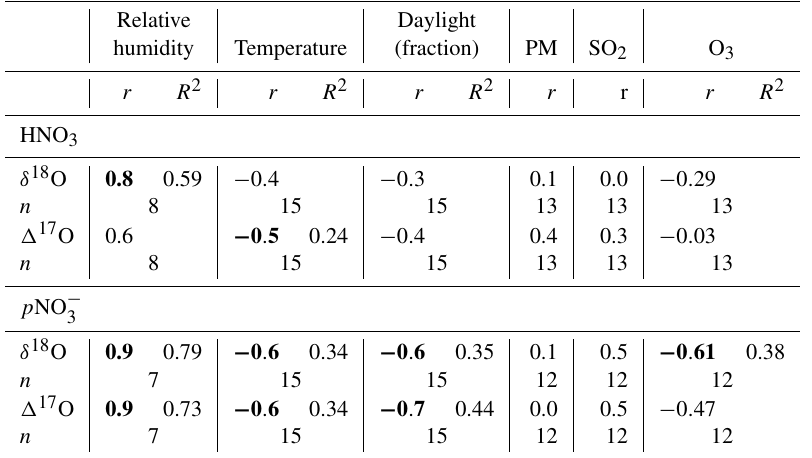
neously sampled p NO − . In practical terms, the relationships 3 between the simultaneously sampled HNO 3 and p NO −